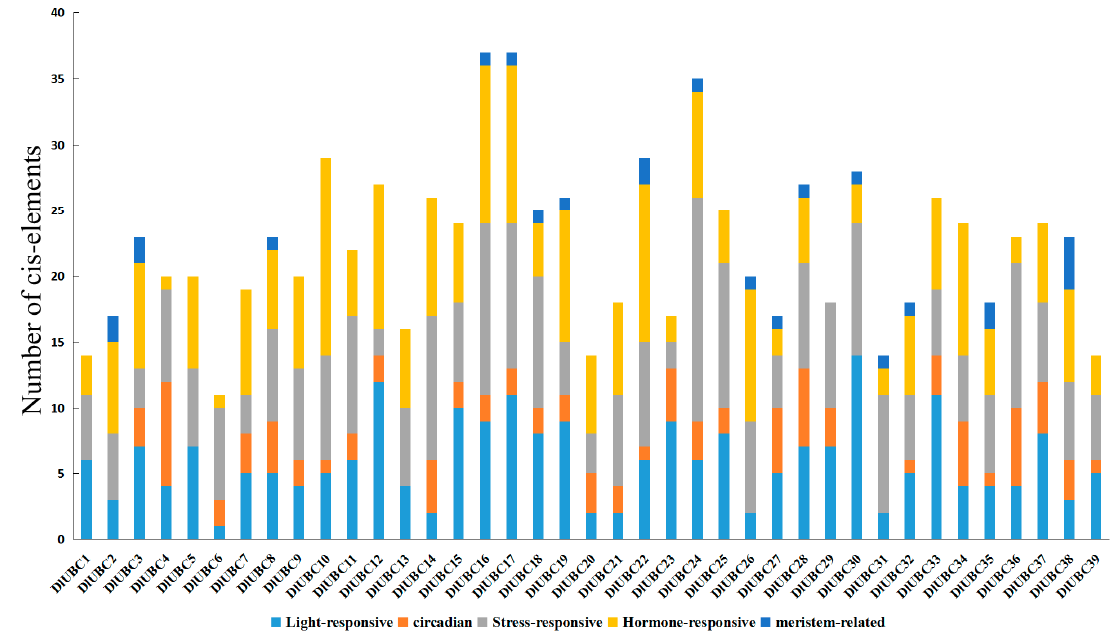
Figure 7. Predicted cis -elements in the promoter of the DlUBC genes. The 1.5 kb sequences of 40 DlUBC genes were analyzed with the PlantCARE software.